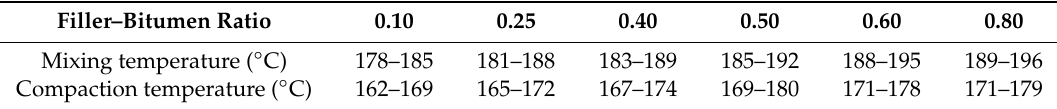
Table 13. Construction temperatures of the CRMB